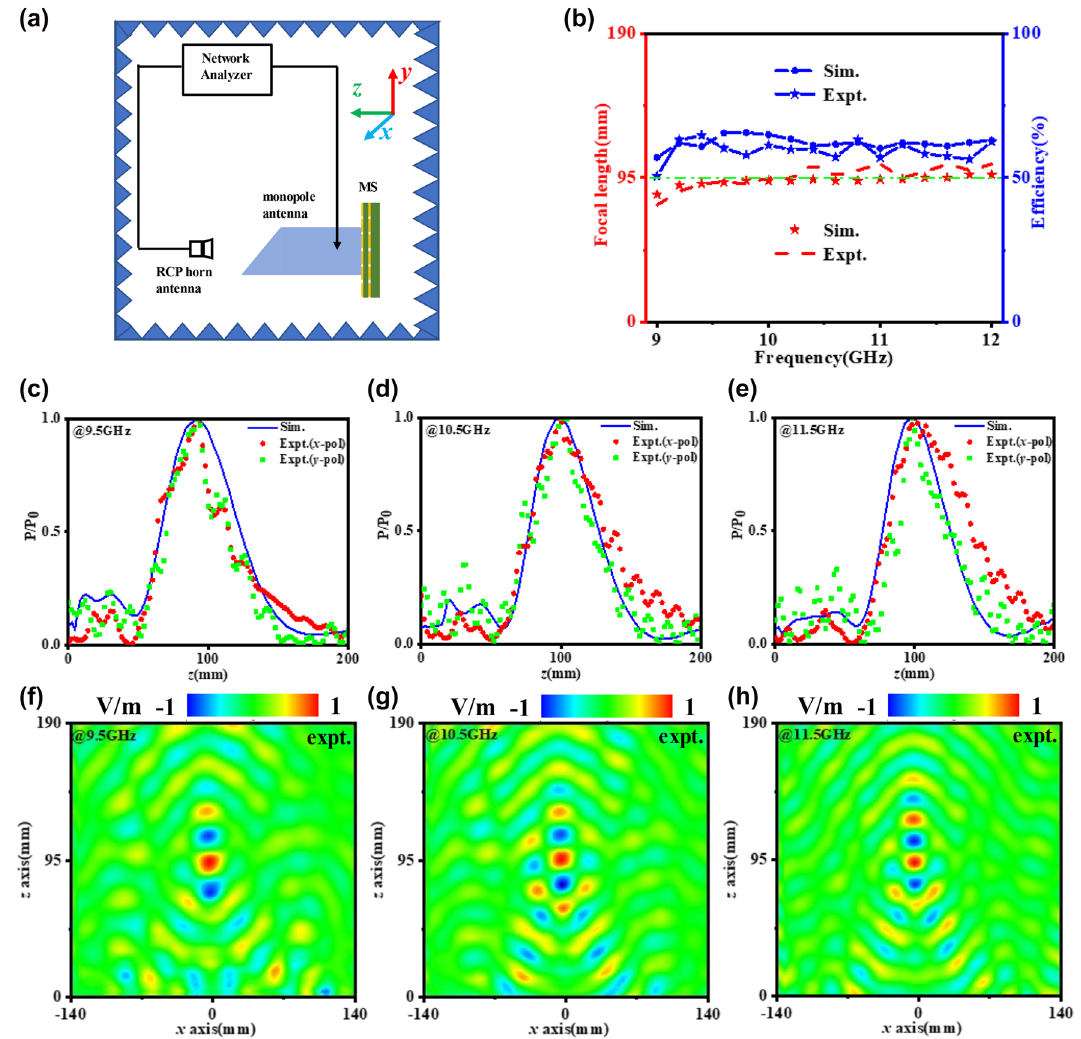
Figure 5: The experimental set ups and results. (a) Schematic of the near field experimental environment. (b) The simulation and experiment working efficiency and focal length varying against frequency. Simulation and experimental normalized energy distribution along z -axis at (c) 9.5, (d) 10.5, and (e) 11.5 GHz. Experiment results of near-field distribution for x -polarization at (f) 9.5, (g) 10.5, (h) 11.5